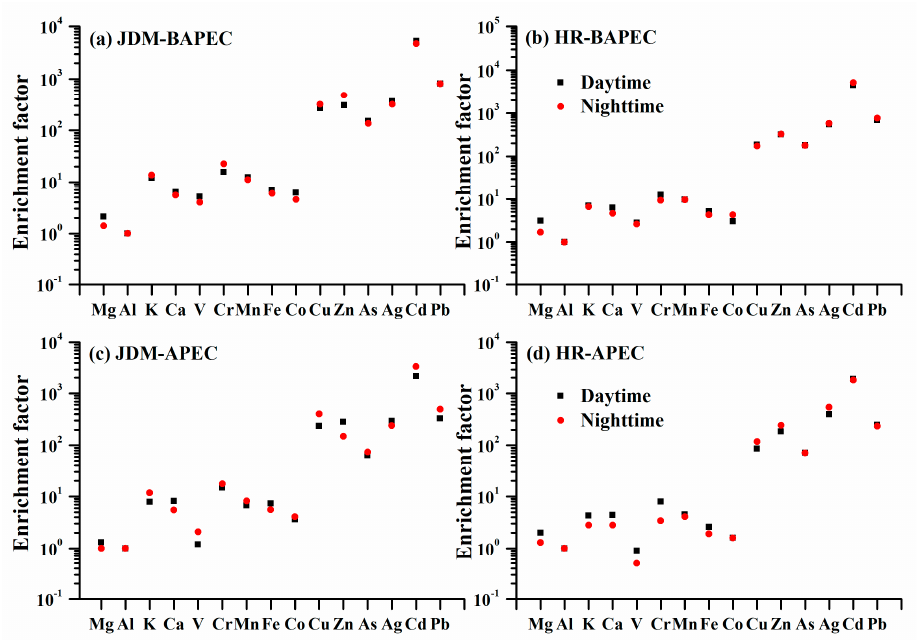
Figure 3. Daytime and nighttime enrichment factors of metallic elements ( a , b ) before and ( c , d ) during the APEC summit in Beijing urban site (JDM) and suburban site (HR).